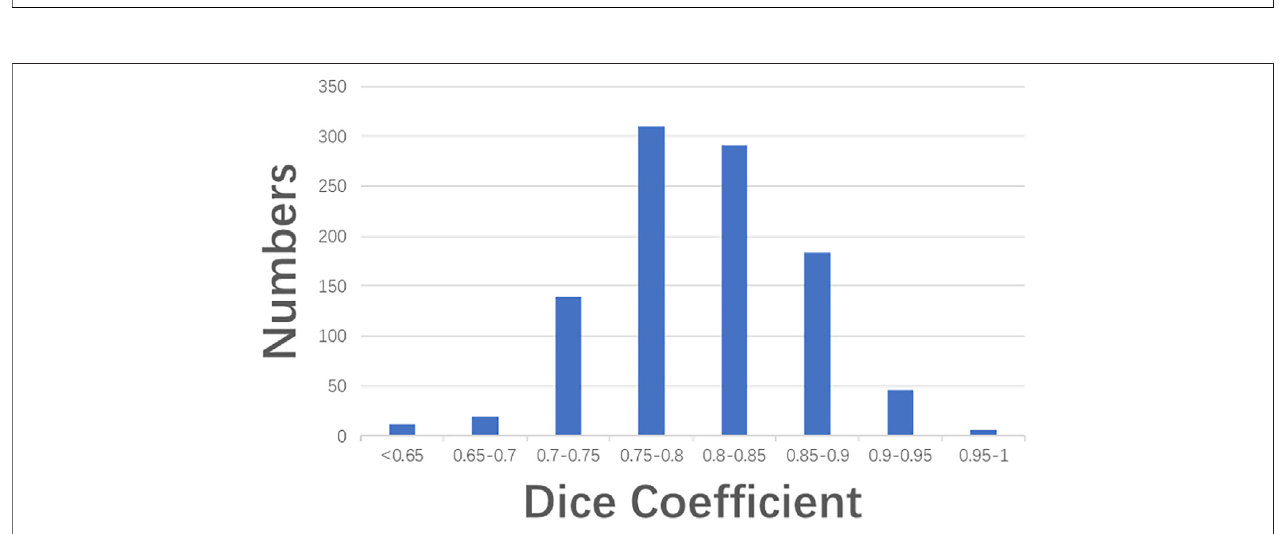
FIGURE 7 | Histogram of Dice coef fi cient in the validation images.